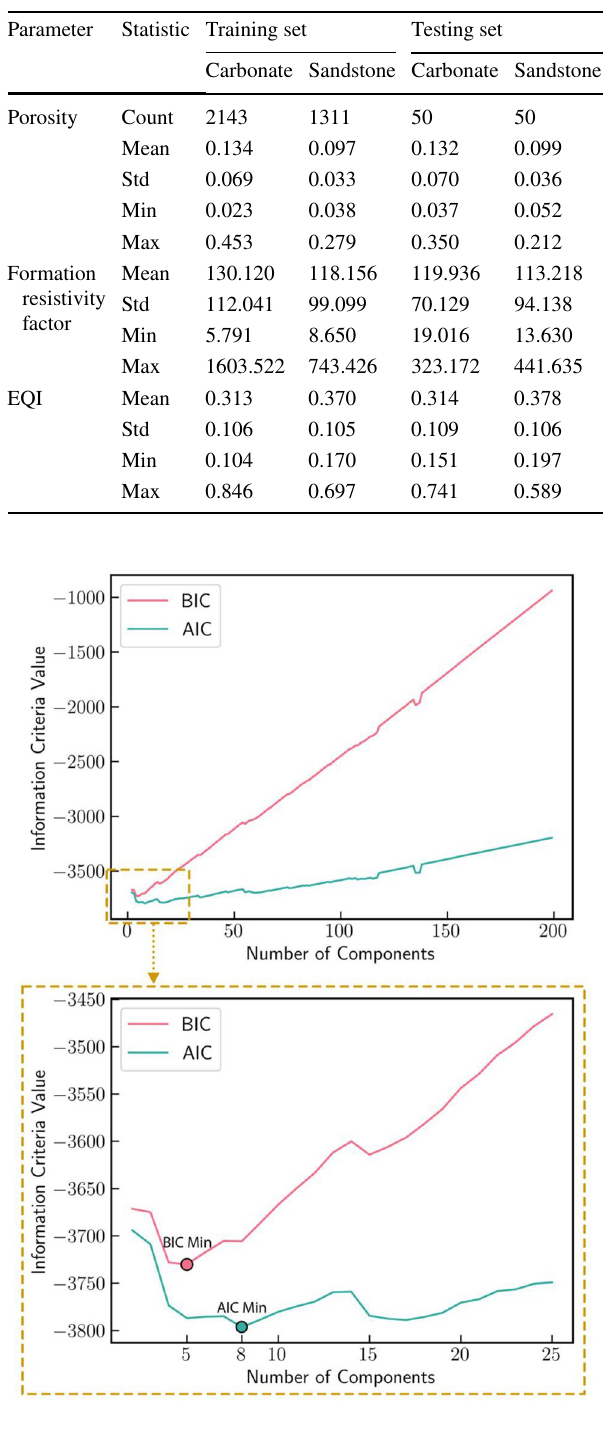
Fig. 4 Calculated BIC and AIC for different numbers of components from 2 to 200 with tied covariance type for carbonate samples